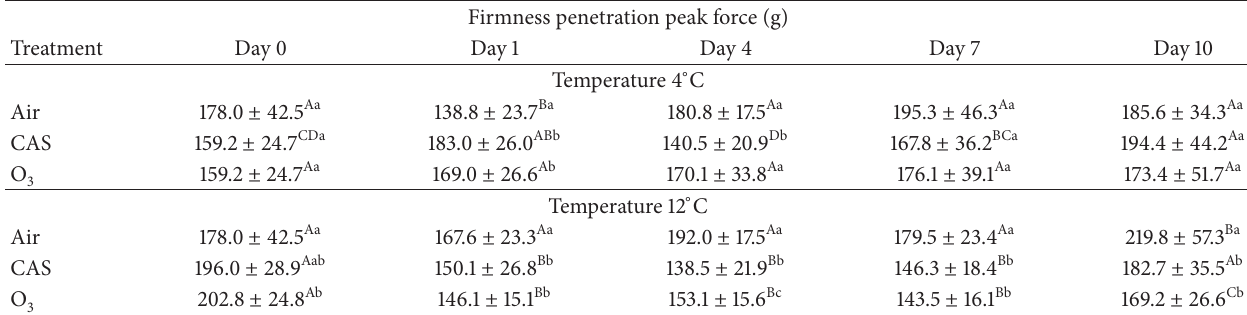
Table 3: Firmness penetration peak force (g) of highbush blueberries stored at 4 ∘ C or 12 ∘ C under controlled atmosphere storage conditions ), or regular atmosphere (Air) during 10 (CAS), ozone (O 3